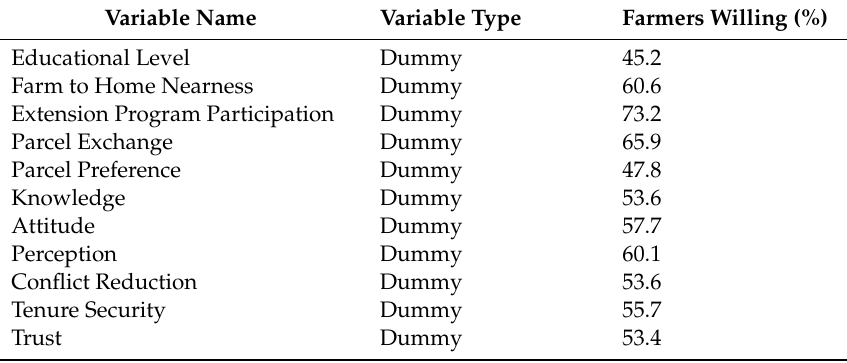
Table 3. Summary of dummy variables used in the logistic regression